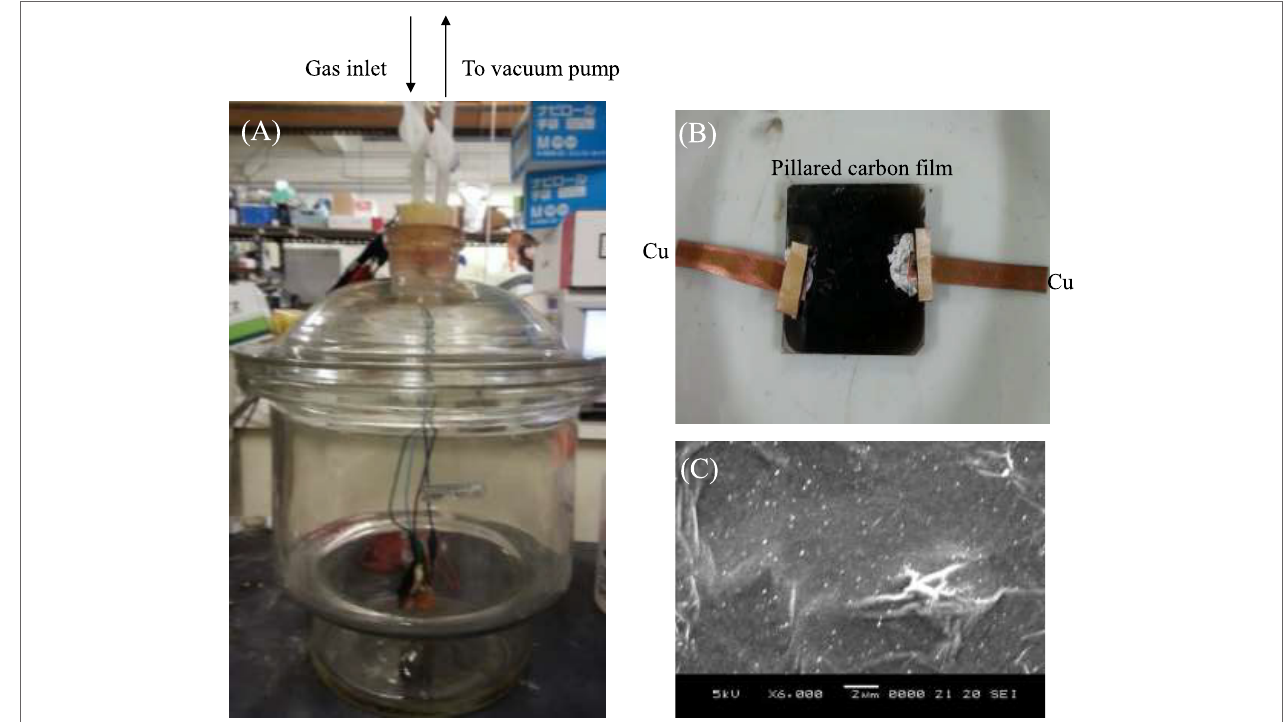
FigUre 1 | The photographs of (a) the chamber used for gas sensing experiment and (B) pillared carbon thin film, together with (c) SEM image of